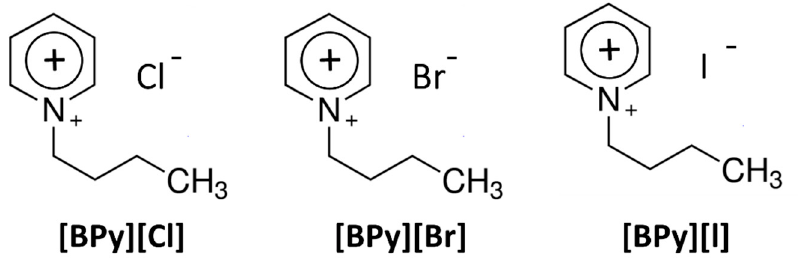
Figure 1. The structure of 1-butylpirydynium: chloride / bromide / iodide ionic liquids.